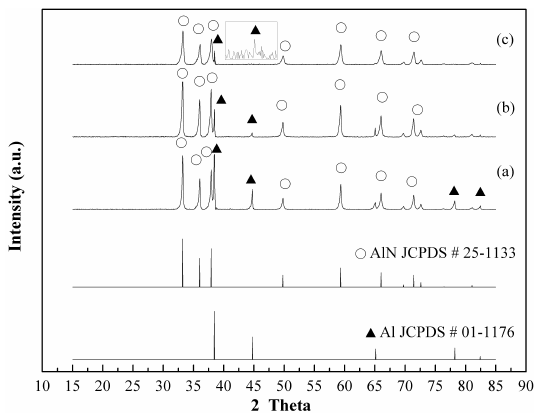
Figure 2. XRD patterns of AlN/Al powders produced by adding various NH 4 Cl contents in Al powders via thermal nitridation process at 850 °C (heating rate: 15 °C/min, held for 1 h) ( a ) 0%, ( b ) 30%, ( c ) 50%.